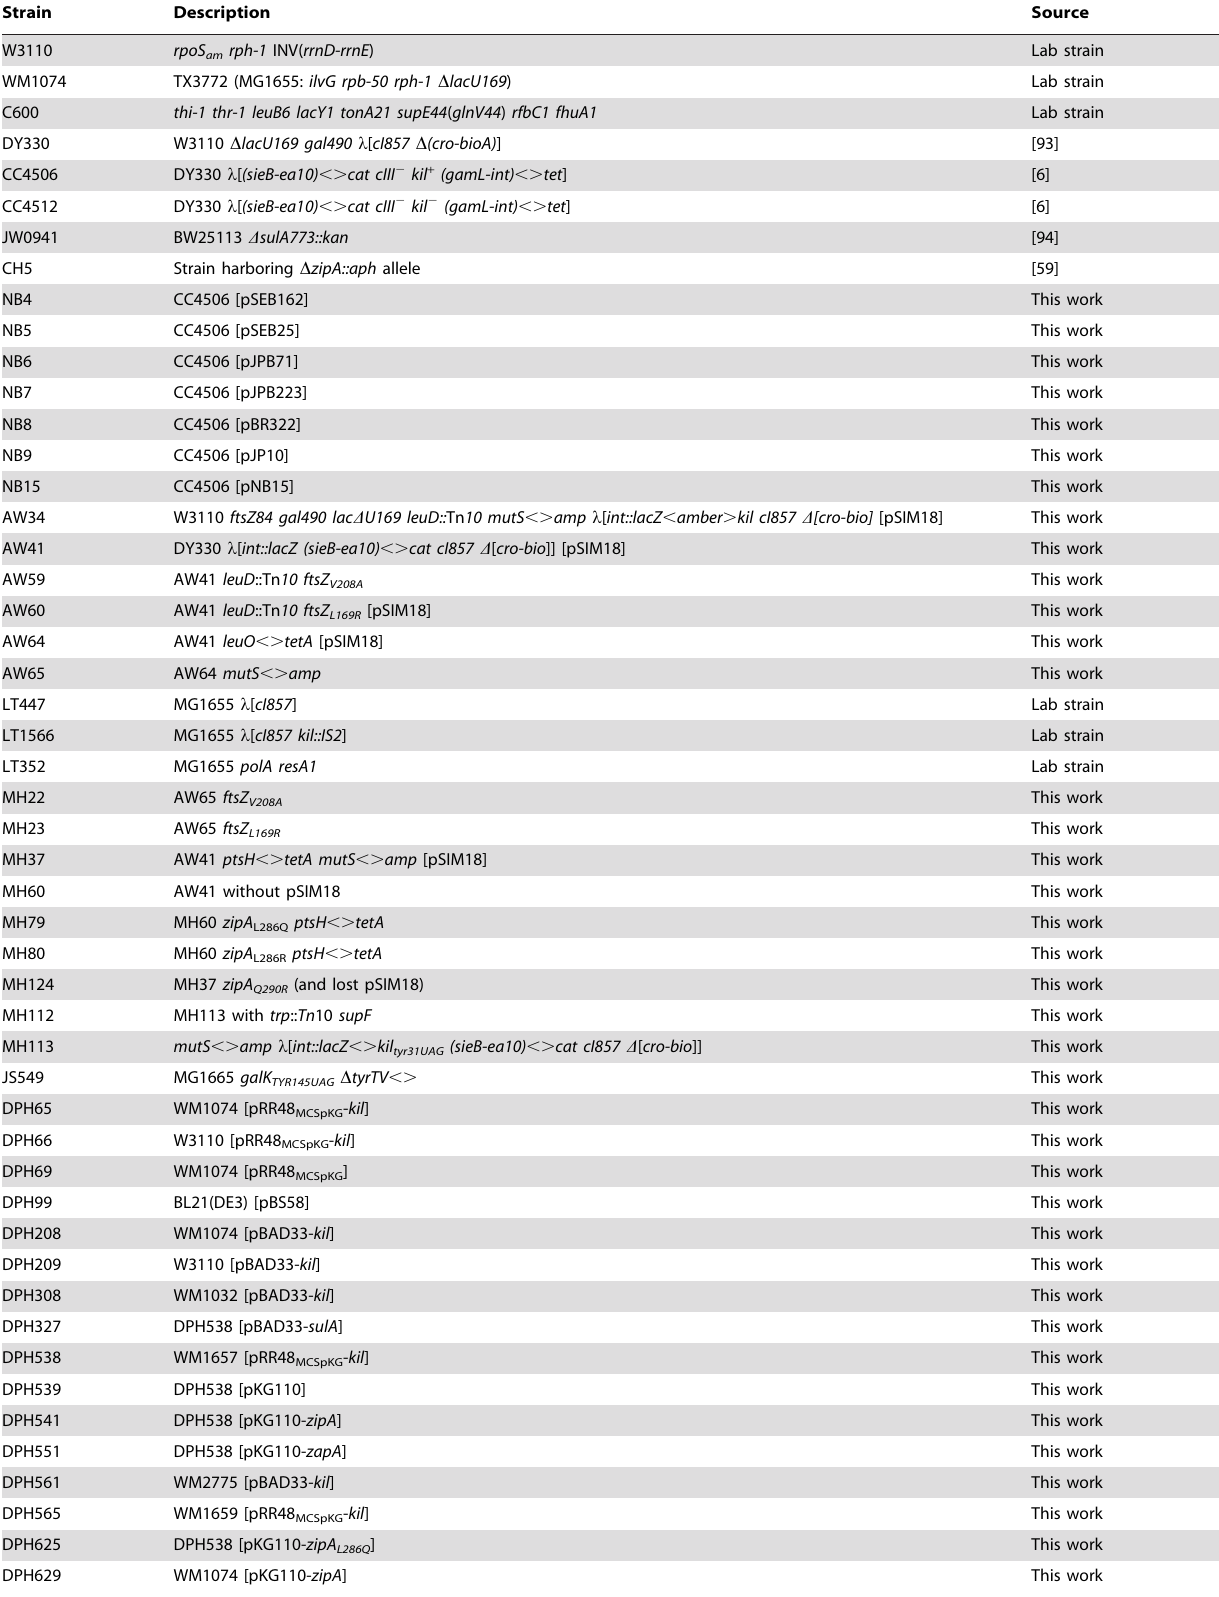
Table 1. Strains used in this study.